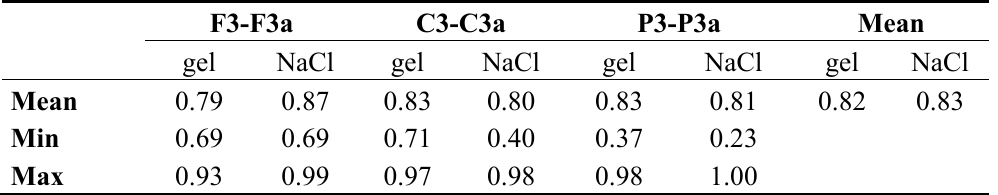
Table 3. Correlation in the time domain between the three pairs of textile electrode Type II and standard electrodes using gel and NaCl, respectively (standard electrodes are denoted with an “a” after the channel name). To the right the grand average is